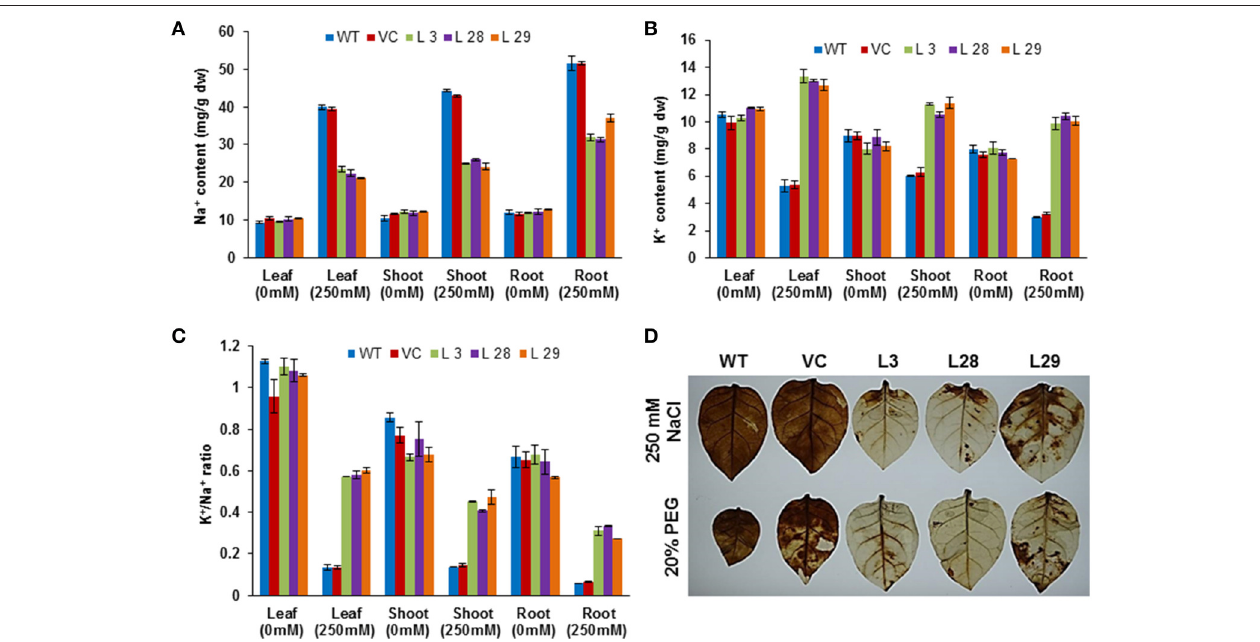
FIGURE 4 | Ion content and detection of H 2 O 2 in T 2 transgenic and wild-type tobacco plants. (A) Na + content in leaves, shoots and roots of transgenic and wild-type plants. (B) K + content in leaves, shoots and roots of transgenic and wild-type plants. (C) K + /Na + ratio with or without salt treatment. Values are means ± SD from three independent trials. (D) In vivo localization of stress-induced H 2 O 2 production in leaves of WT, VC and SbSLSP –overexpressing transgenic lines after stress treatment by staining with